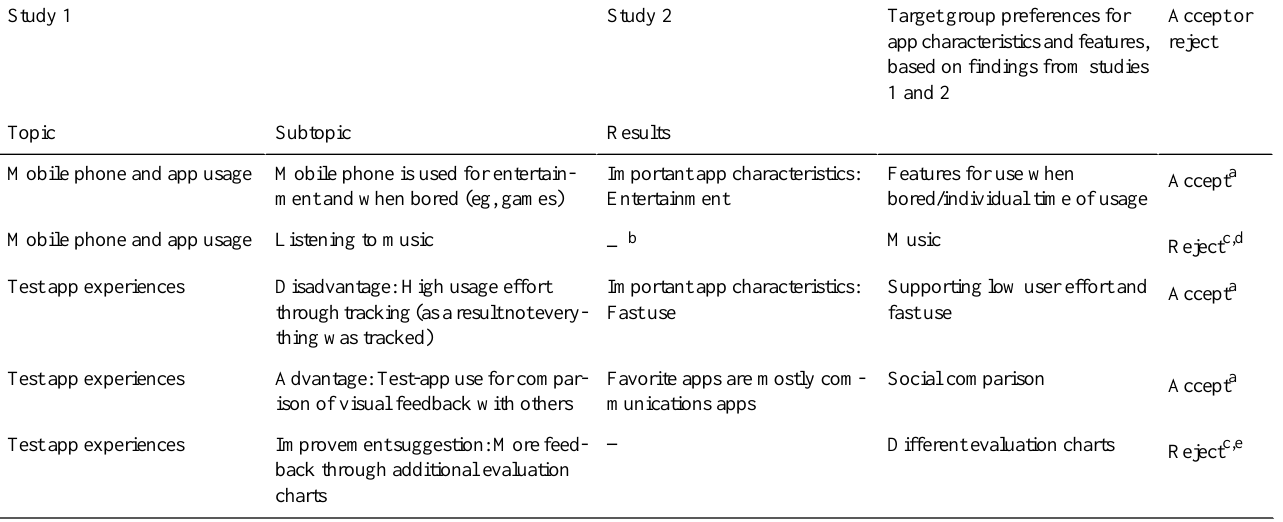
Table 2. Excerpt of identified and selected target group preferences for app characteristics and